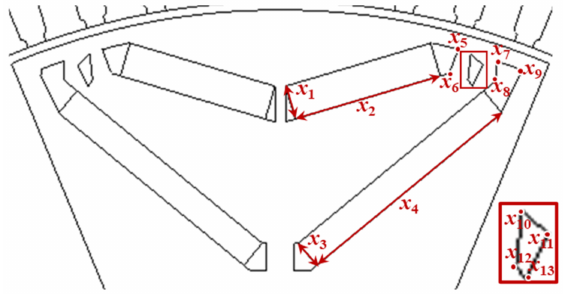
Figure 13. Design variables of the optimal model.